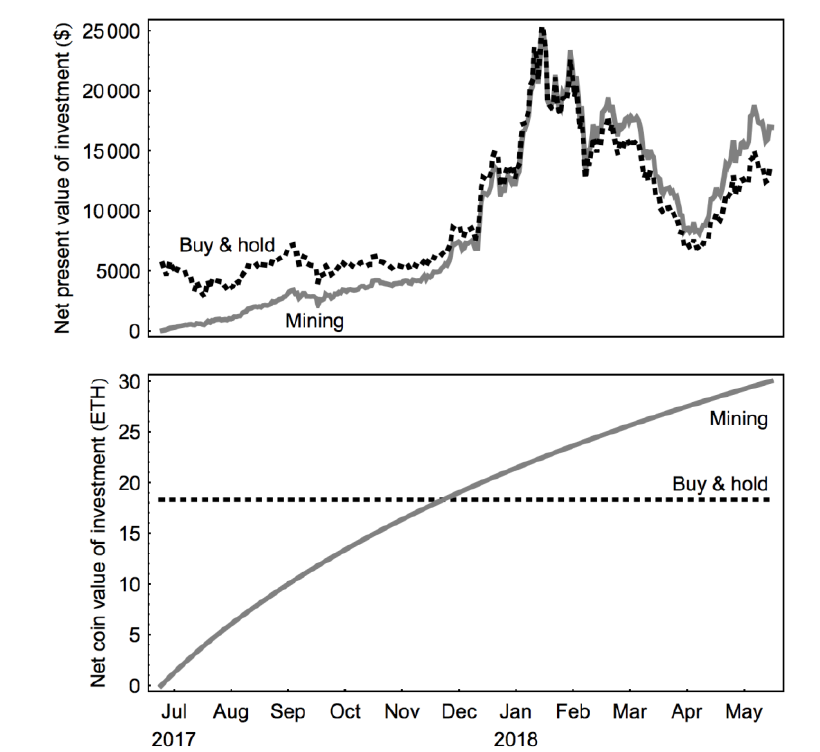
Fig. 4. Top: Net Present Value at a 0% discount rate is used to compare mining to the buy- and-hold investment strategy. Bottom: Net Coin Value is used for same case. The Net Coin Value method is more stable when the coin price volatility is